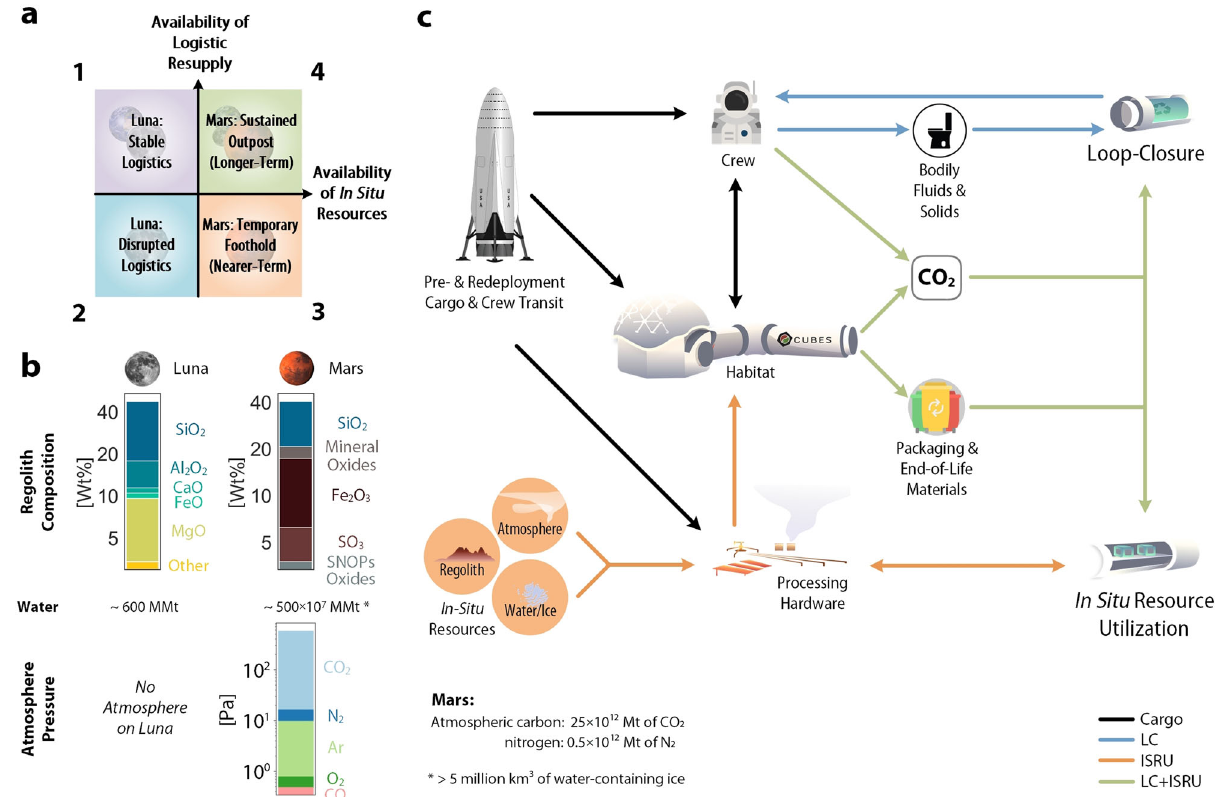
Fig. 1 | Approaches to in situ biomanufacturing (bio-ISM) depending on off- world mission-class. The context-speci fi c off-world mission-classes 1 to 4 are de fi ned in ( a ), mapped as quadrants on qualitative spectra for the availability of in situ resources and logistic resupply. The most ubiquitous surface-accessible in situ resources for the Moon 101 and Mars 102 are compared in ( b ) in form of gases and solids, broken down into their molecular compositions (SNOPs: sulfur, nitro- gen, oxygen, phosphorus. Note that SNOPs and mineral oxides exclude otherwise